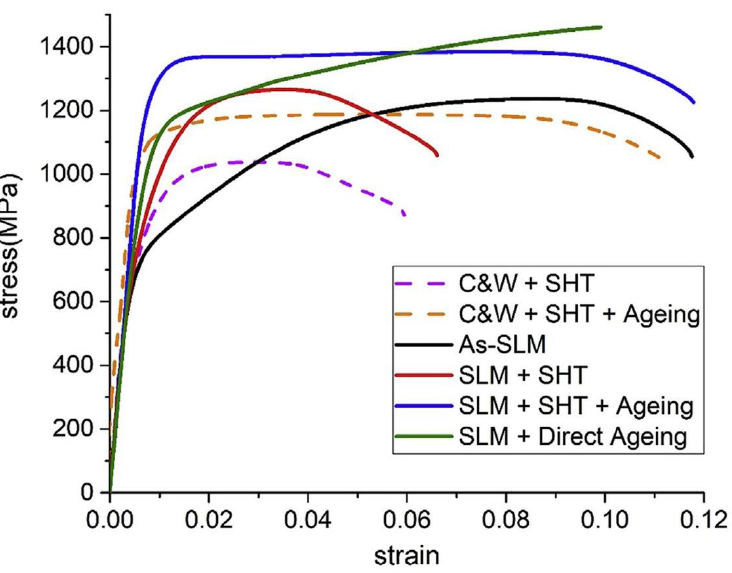
Figure 14. Tensile response of SLM processed samples compared with conventional casting tech- niques subjected to various heat treatments [162]. (Reprinted with permission from Ref. [162]. Copyright 2019 Elsevier).